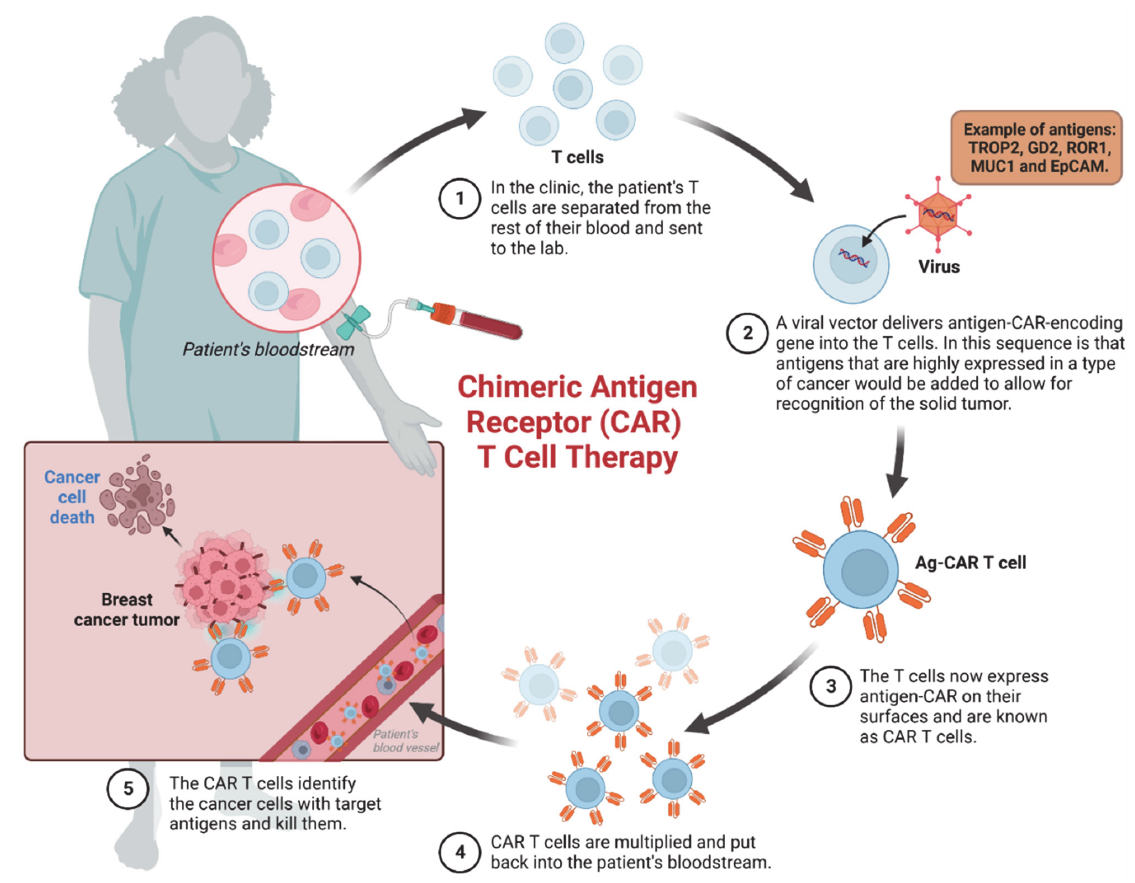
Figure 2. Chimeric Antigen Receptor (CAR)-T Cell Therapy for breast cancer. Step-by-step process of CAR-T cell therapy development. CAR-T cell therapy